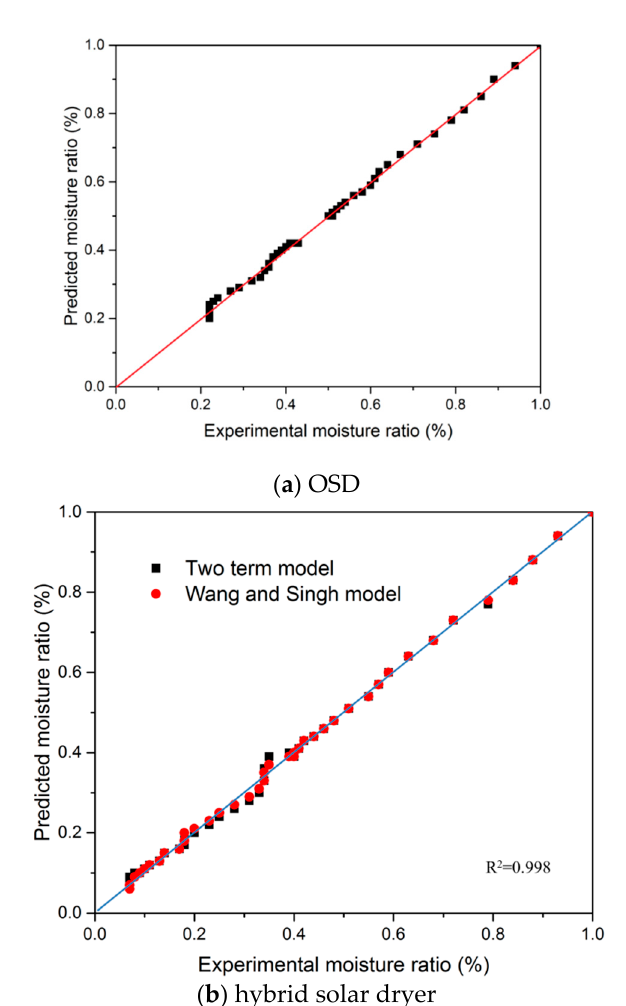
Figure 10. The relationship between predicted and experimental values for lemon slices’ drying.